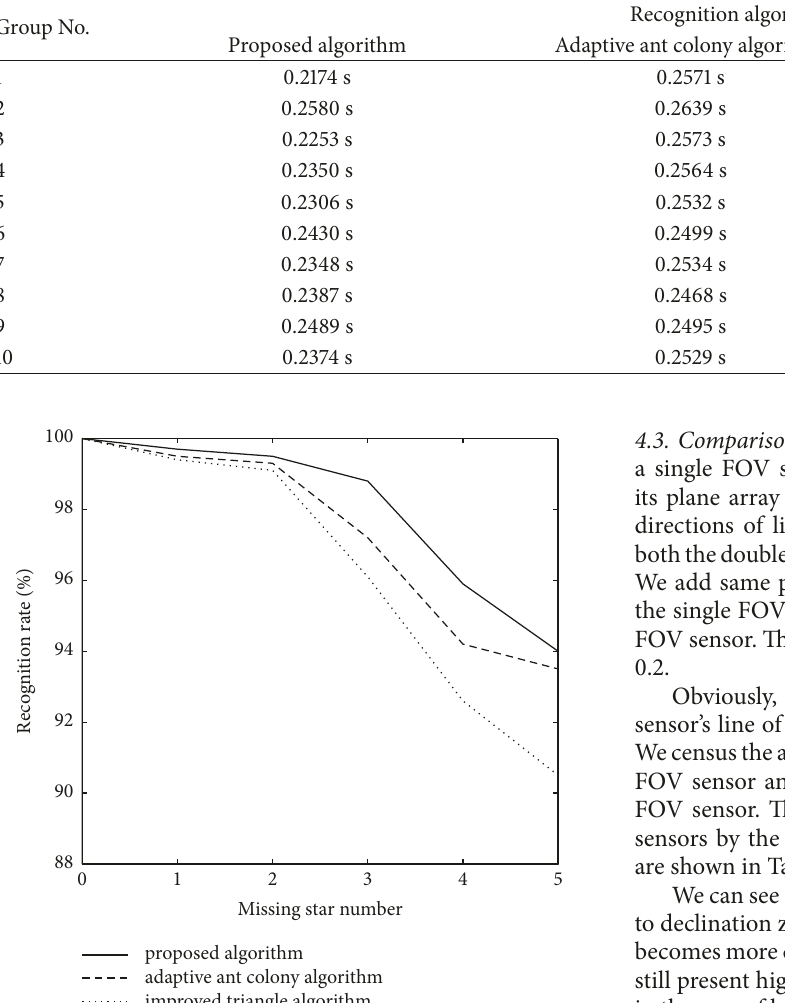
Table 1: Recognition time of different algorithms.